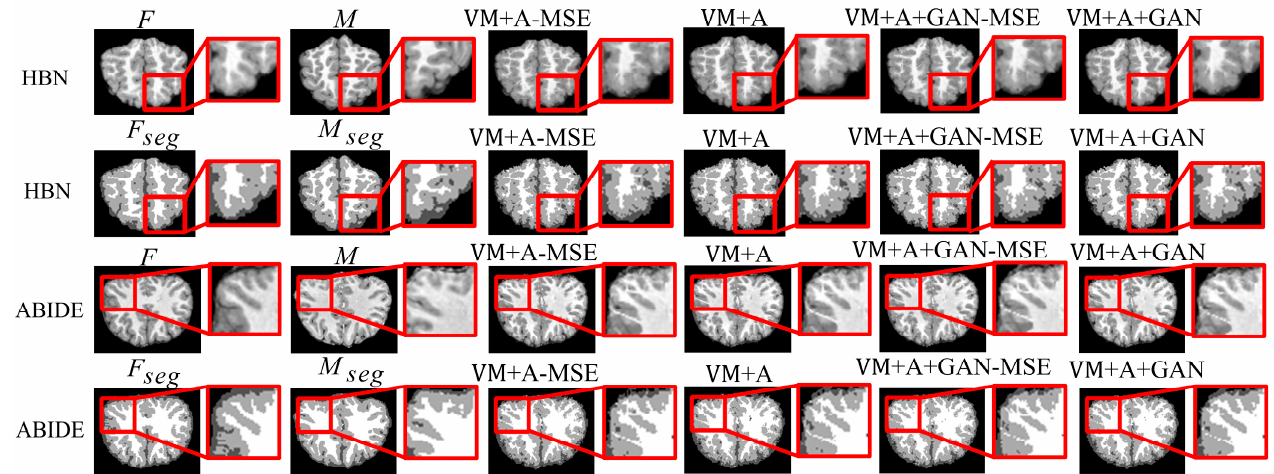
Figure 7. Experimental results regarding the use of the MSE loss function when employing the HBN and ABIDE datasets. Among them, VM + A − MSE indicates that the MSE loss function has been removed when training the registration network and the enhanced network, VM + A indicates the experimental results when the MSE loss function is retained when training the registration network and the enhanced network, VM + A + GAN − MSE indicates our method’s experimental results following the removal of the MSE loss function, and VM + A + GAN represents our experimental results with the MSE loss function retained. Table 5. Dice values when using the MSE loss function and the HBN and ABIDE datasets. Bold numbers indicate the best results.